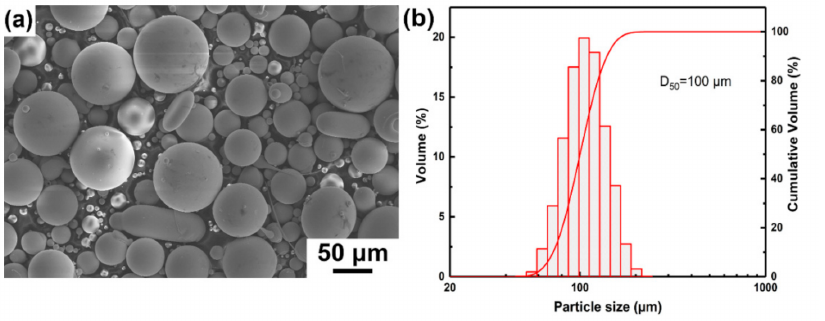
Figure 2. ( a ) Particle morphology and ( b ) particle size distribution of the gas-atomized Zr 48 Cu 36 Al 8 Ag 8 glassy powder. Table 1. Chemical composition of the Zr 48 Cu 36 Al 8 Ag 8 glass powder (at.%). Zr